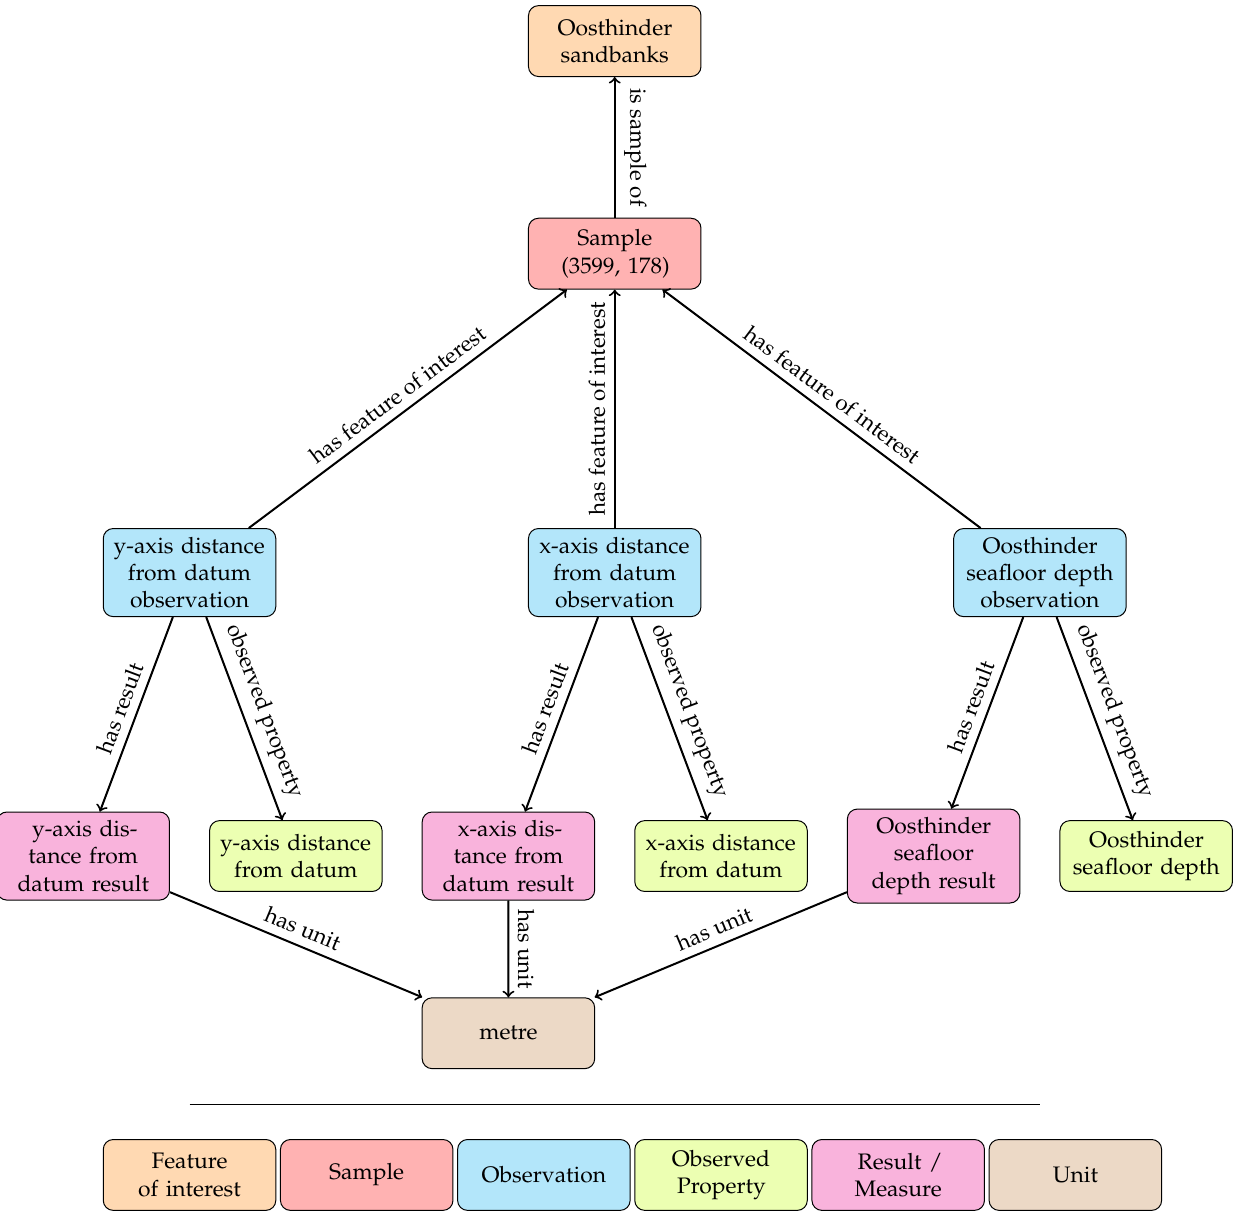
Figure 6. Example semantic representation of bathymetry observations (using OM